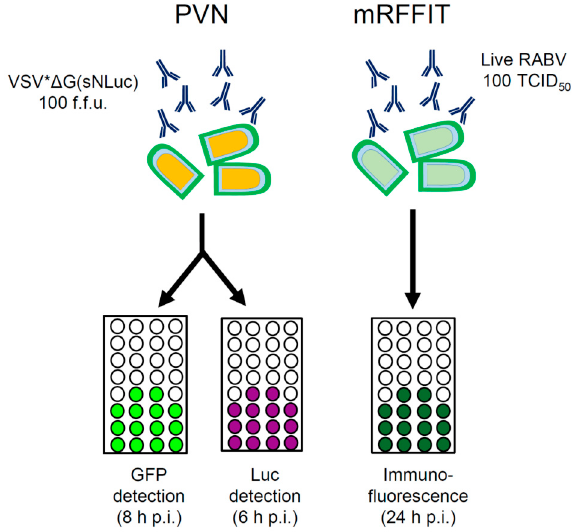
Figure 5. Performance of the PVN compared to the modified RFFIT. The PVN test makes use of propagation ‐ incompetent pseudotype particles that express two reporter proteins, GFP and luciferase. The modified RFFIT makes use of live RABV and requires high biosafety standards. The different read ‐ outs and time requirements of the assays are indicated. TCID 50 : median tissue culture infective dose.